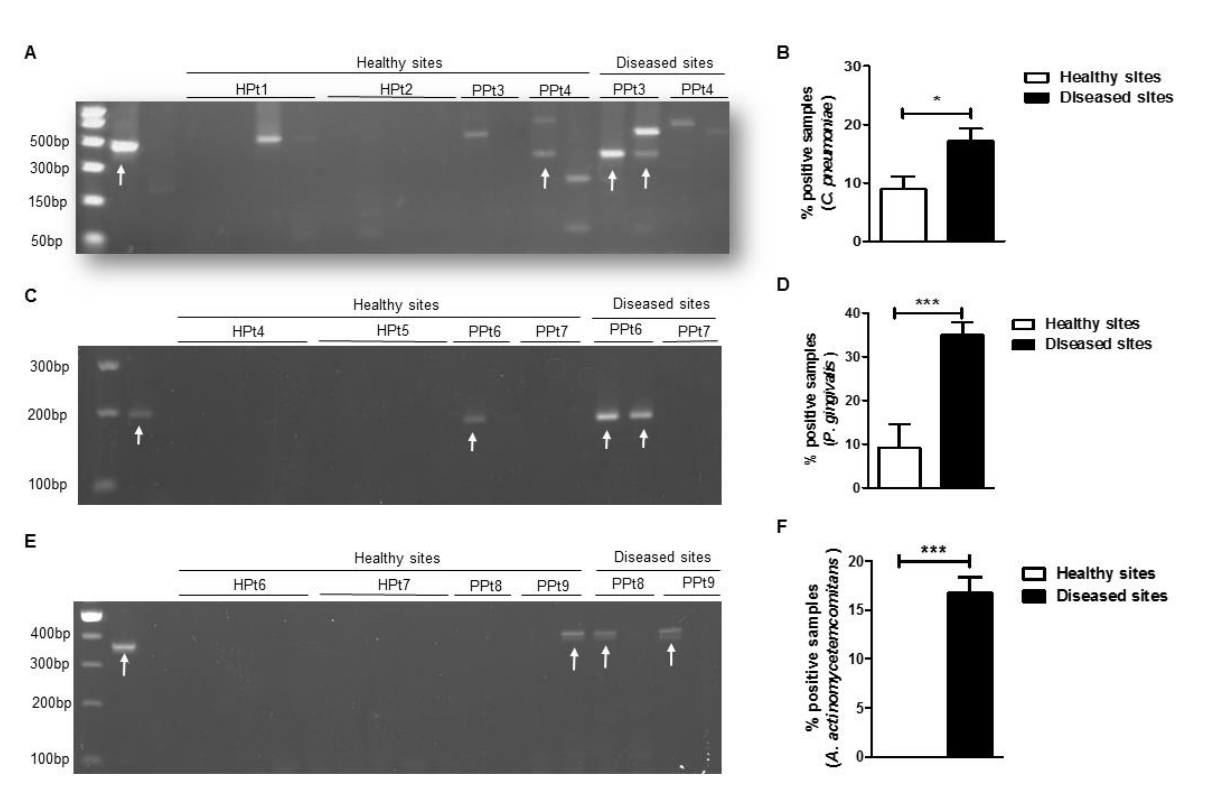
FIGURE 1: C. pneumoniae is present more frequently in subgingival plaque obtained from periodontally diseased sites vs. healthy sites. Dental plaques were obtained from subgingival locations in ten healthy patients (HPt, four sites for each one) and in ten patients with peri- odontal disease (PPt). For patients with periodontal disease, subgingival dental plaques were obtained from both areas with periodontitis (P, two sites per subject) and areas without periodontitis (H, two sites per subject). All dental plaque samples were subjected to PCR fol- lowed by agarose gel electrophoresis. (A, C, E) Representative gel electrophoretogram of PCR products screening C. pneumoniae (A) , P. gingivalis (C) and A. actinomycetemcomitans (E) . Quantification of C. pneumoniae (B) , P. gingivalis (D) and A. actinomycetemcomitans (F) 16S rRNA, PCR products. (B, D, F) Healthy sites: n = 40 (only from healthy donors) and diseased sites: n = 20. For each dental plaque sample, seven different runs were performed for C. pneumoniae and three different runs for P. gingivalis and A. actinomycetemcomitans. Arrows indicate positive bands in the expected bp size. Error bars represent ± SD; 2- sided, paired Student’s t test, * P < 0.05,